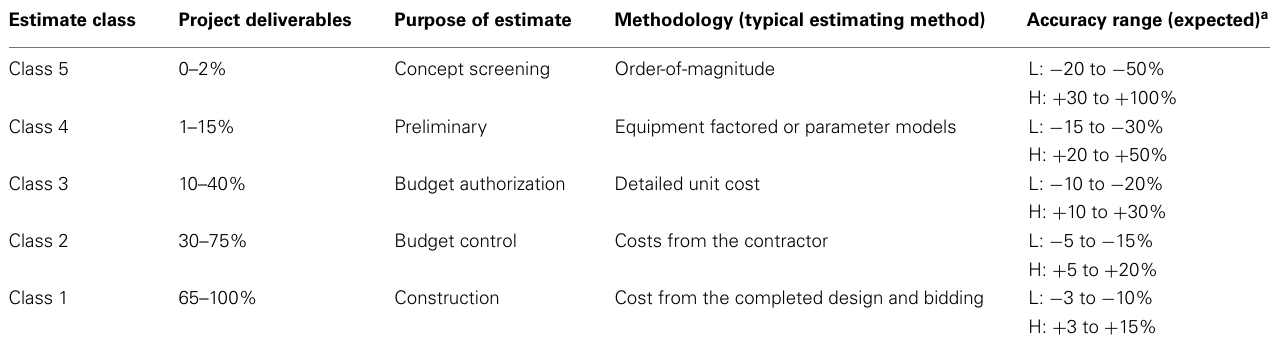
Table 1 | Cost estimate classification matrix for the process industries [adapted from Christensen and Dysert (2011)] .